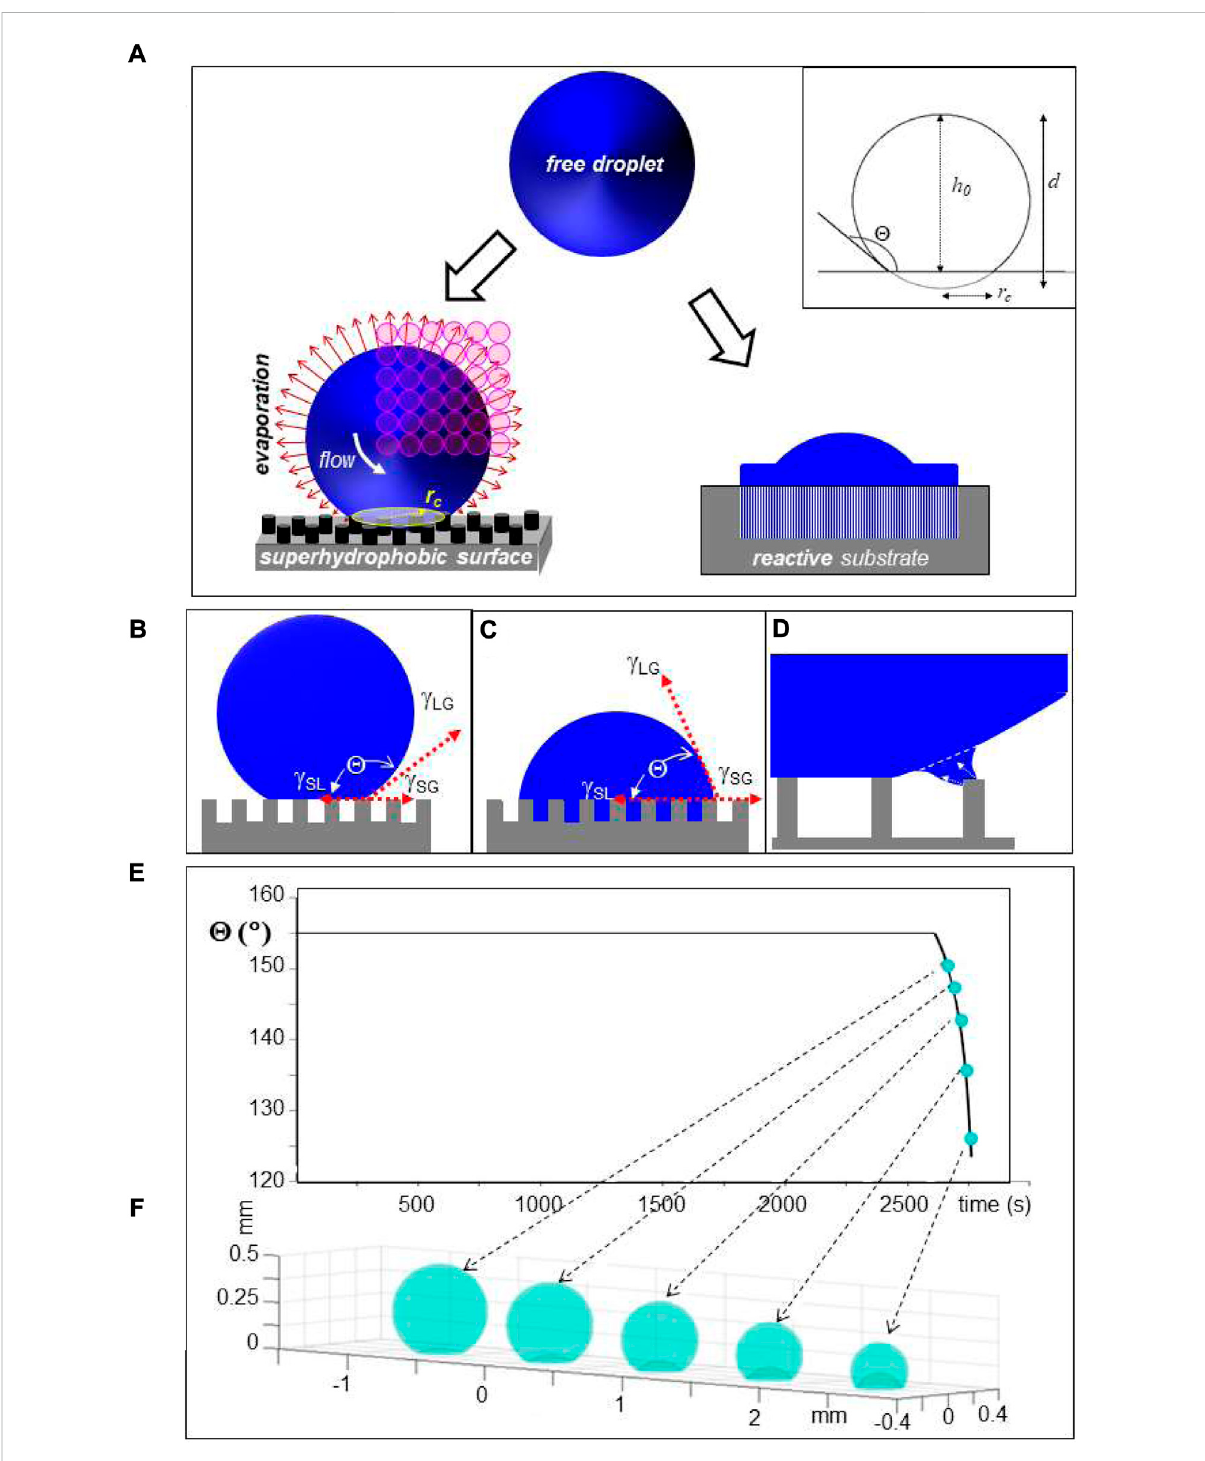
FIGURE 1 (A) Schematic design of droplet deposition. Left: Droplet deposited on a pillared SHS with a circular contact area of radius r c . The inset shows schematically the geometry of a deposited droplet. Selected geometric parameters are indicated in Table 1. Bulk fl ow is induced by surface evaporation.AmeshofSRprobingpositionsisdepictedbyopencirclesdepictingthefocalspot.Right:Cutthroughdropletwhichhaspartiallyspread on surface with low Θ -value and reacted with underlying substrate. (B) Unpinned Cassie – Baxter ( “ Fakir ” ) state of water droplet on pillared SHS. γ γ γ SG , SL and LG are the interfacial surface energies between solid (S), liquid (L) and gas (G) phases and equilibrium (Accardo et al., 2014). (C) Pinned Wenzel state. (D) Retraction of contact-line of the droplet from the outermost pillars of a pillared SHS during evaporation(Allione etal., 2021). (E) Simulation ofchange in Θ for a6 μ Ldroplet during evaporationatr. t. The decrease of Θ above t~2,600 s is due to the wetting transition. (F) Simulation of droplet shape change during wetting transition; E/F: adapted from: (Accardo et al.,